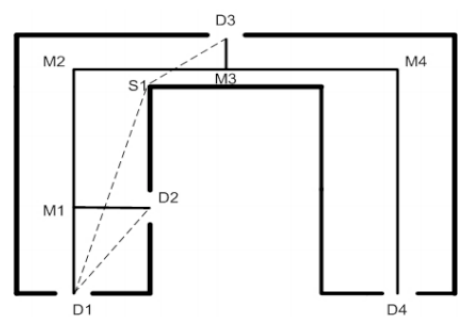
Figure 1. Cell centres and paths overlaid with a floor Plan (Stoffel et al., 2006)